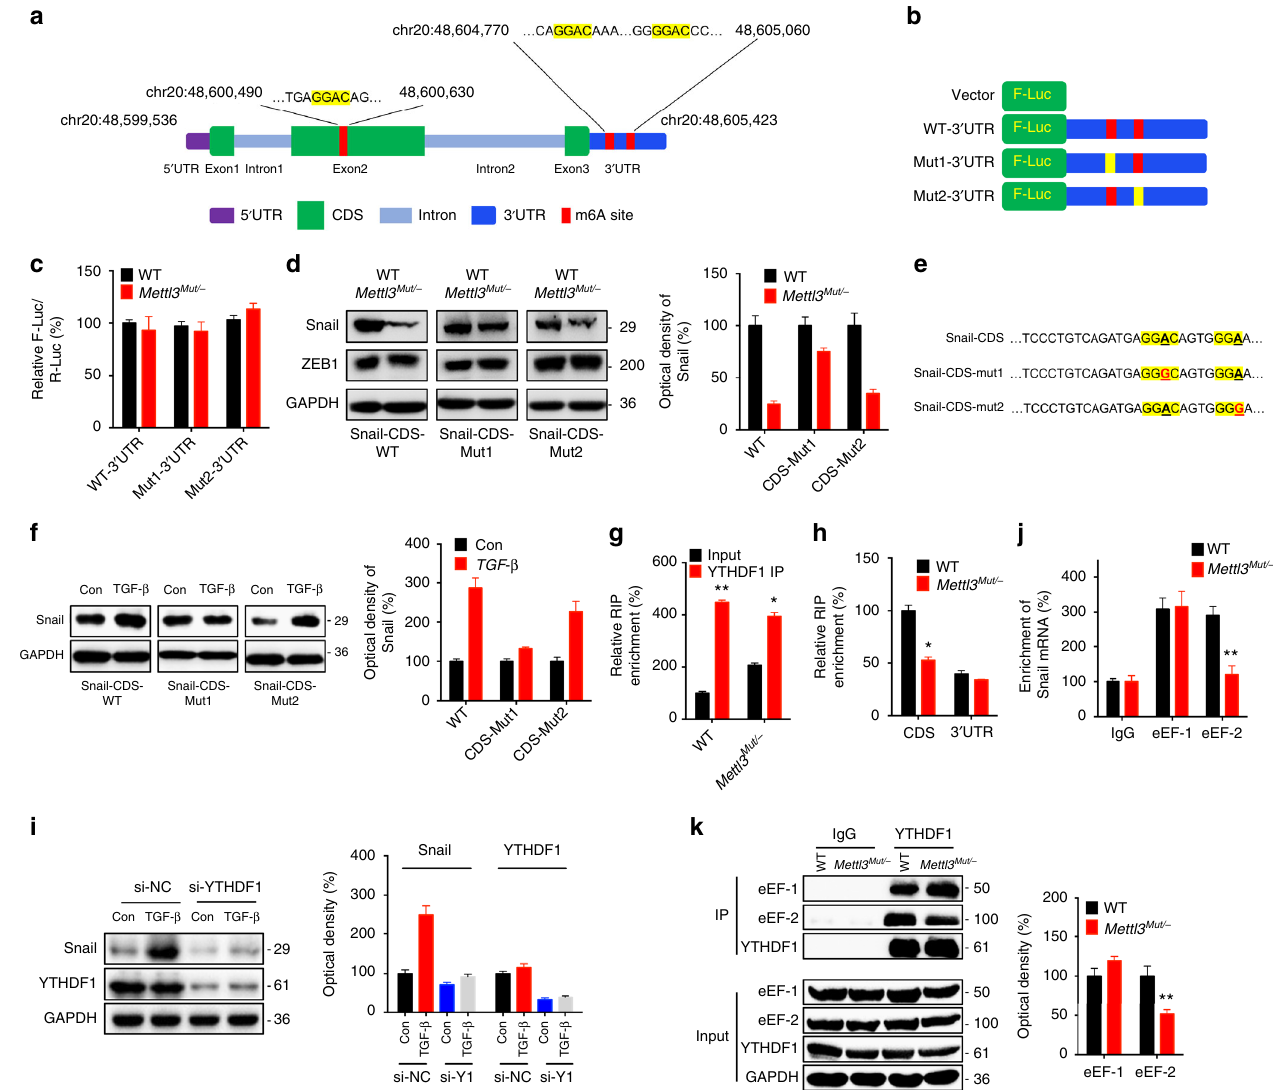
Fig. 5 m 6 A methylated CDS regulates translation of Snail. a Schematic representation of positions of m 6 A motifs within Snail mRNA. b Schematic representation of mutated (GGAC to GGCC) 3 ’ UTR of pmirGLO vector to investigate the m 6 A roles on Snail expression. c pmirGLO-3 ′ UTR or pmirGLO-3 ′ UTR-Mut1/2 reporter was transfected into wild-type or Mettl3 Mut/ − HeLa cells for 24 h. d pcDNA-Snail-CDS-WT, pcDNA-Snail-mut1/2, or pcDNA/ZEB1 were transfected into HeLa cells for 24 h. Protein expression was measured by western blot analysis (left) and quantitatively analyzed (right). e Schematic representation of mutation in CDS to investigate the m 6 A roles on Snail expression. f After transfected with pcDNA-Snail-CDS-WT or pcDNA-Snail-mut1/ 2, HeLa cells were further treated with or without 10 ng/ml TGF- β for 48 h. The expression of Snail was measured by western blot analysis (left) and quantitatively analyzed (right). g YTHDF1 RIP-qPCR analysis of SNAI1 mRNA in wild-type or Mettl3 Mut/ − HeLa cells. h Binding of YTHDF1 with the CDS or 3 ’ UTR in wild-type or Mettl3 Mut/ − cells were analyzed by YTHDF1 RIP-qPCR using fragmented RNA. i After pre-transfected with siNC or si-YTHDF1 for 12 h, HeLa cells were further treated with or without 10 ng/ml TGF- β for 48 h. Protein expression was measured by western blot analysis (left) and quantitatively analyzed ( right ). j eEF-1 and eEF-2 RIP-qPCR analysis of SNAI1 mRNA in wild-type or Mettl3 Mut/ − HeLa cells. k Binding between YTHDF1 with eEF-1 or eEF-2 in wild-type or Mettl3 Mut/ − HeLa cells was checked by immunoprecipitation (left) and quantitatively analyzed (right). Data are presented as means ± SD from three independent experiments. * p < 0.05, NS, no signi fi cant, by Student ’ s t test